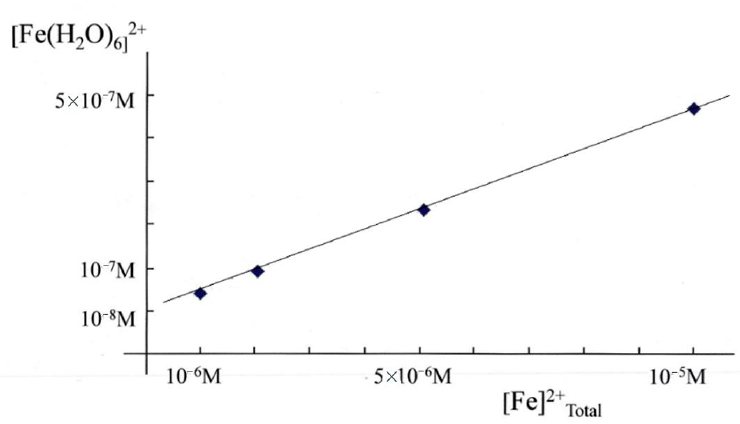
Figure 4. Variation of [Fe(H 2 O) 6 2+ ] ( 1 ) with [Fe 2+ ] total in the presence of 8 mM GSH at pH 7.0.